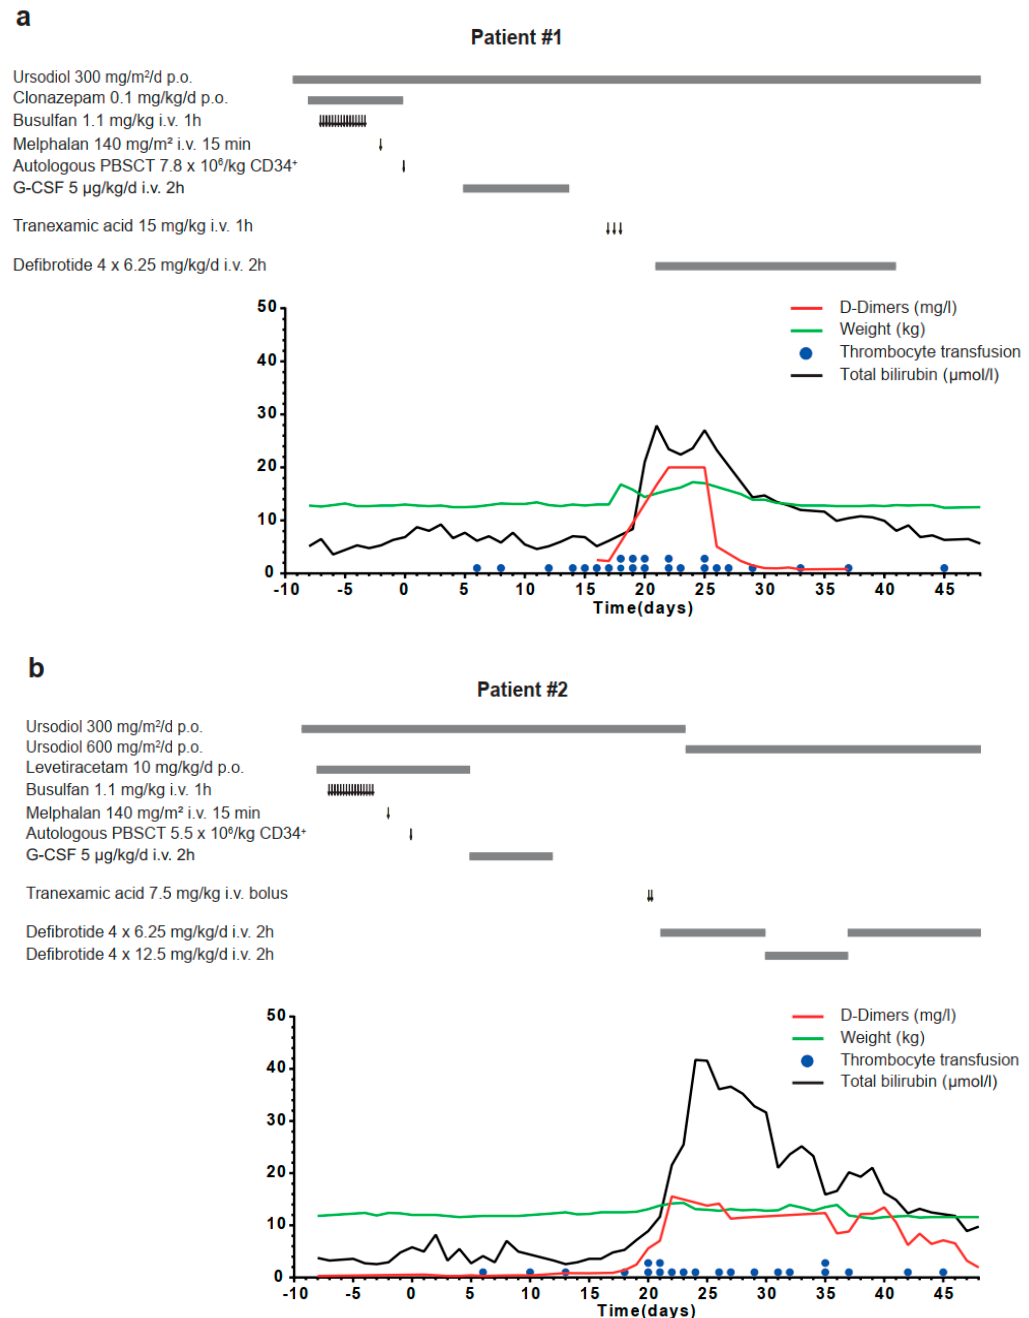
Figure 1. Schematic diagram illustrating medical interventions, clinical signs and laboratory parameters of a 4-8 / 12-year-old INRG stage M neuroblastoma patient ( a ) and a 1-10 / 12-year-old INRG stage M neuroblastoma patient ( b ) receiving myeloablative chemotherapy and autologous stem cell rescue. Arrow, therapy application; bold grey line, treatment interval; red line, D-dimer values (mg / L); black line, total bilirubin level (mmol / L); green line, body weight (kg); blue dots, thrombocyte transfusions. CD: cluster of differentiation; G-CSF: granulocyte colony-stimulating factor; INRG: International Neuroblastoma Risk Group; PBSCT: peripheral blood stem cell transplantation.